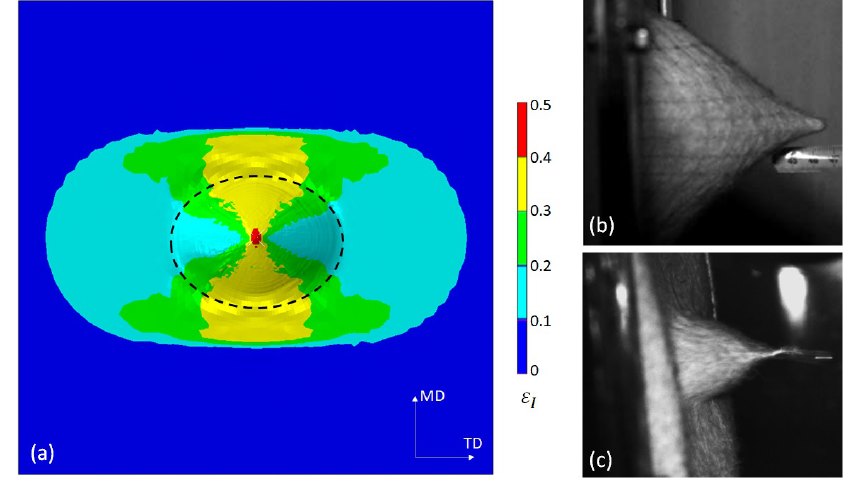
Figure 5. Deformation of a 350 × 350 mm 2 target impacted by a small steel sphere of 5.5 mm diameter. Ballistic response for initial impact velocity 300 m/s at t = 500 µ s, below the ballistic limit. ( a ) Contour plot of the maximum principal logarithmic strain, showing the fronts of the longitudinal and transverse waves (dashed line) and ( b ) experimental deflection. ( c ) Fibre disentanglement for impact velocity 360 m/s at t = 175 µ s, above the ballistic limit